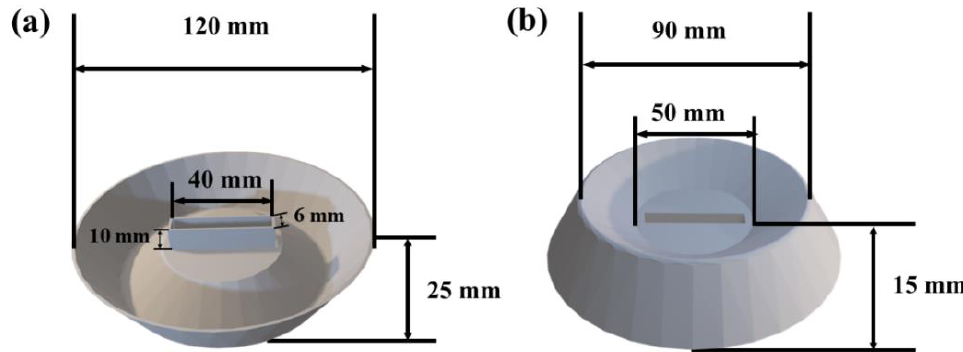
Figure 3. Buoyancy layer model: ( a ) front view; ( b ) back view.